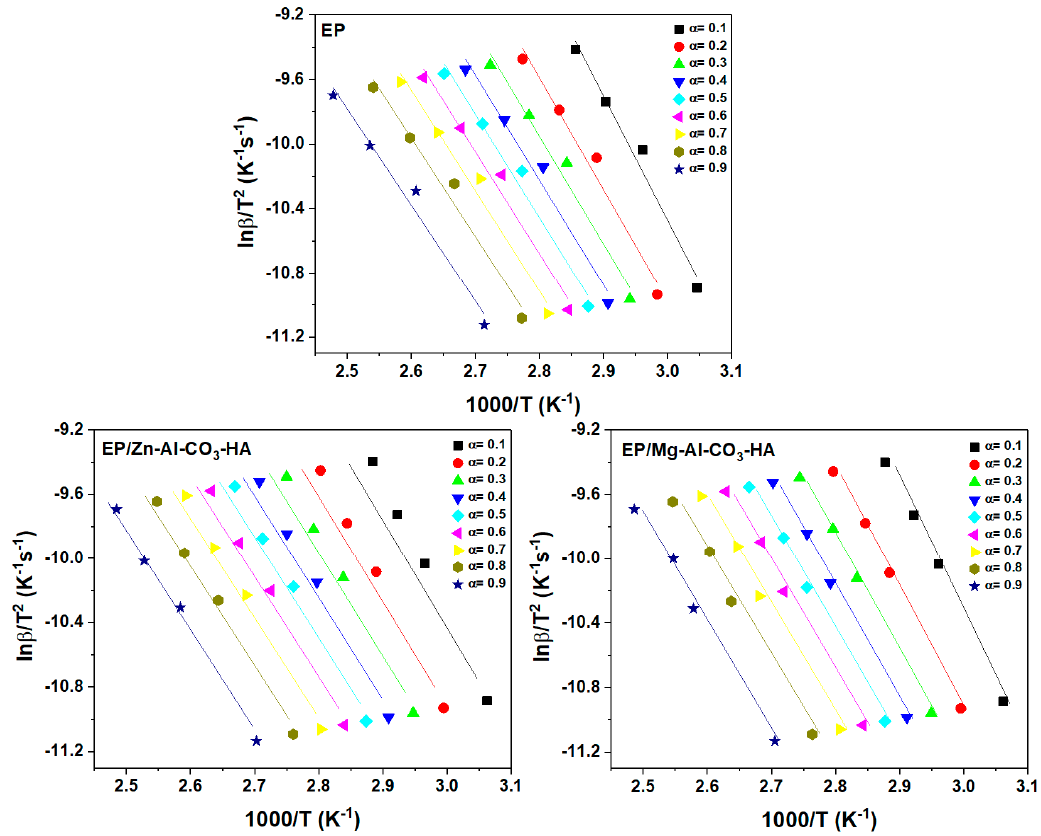
Figure A2. Fitting plots for the neat epoxy and its nanocomposites based on the KAS model.